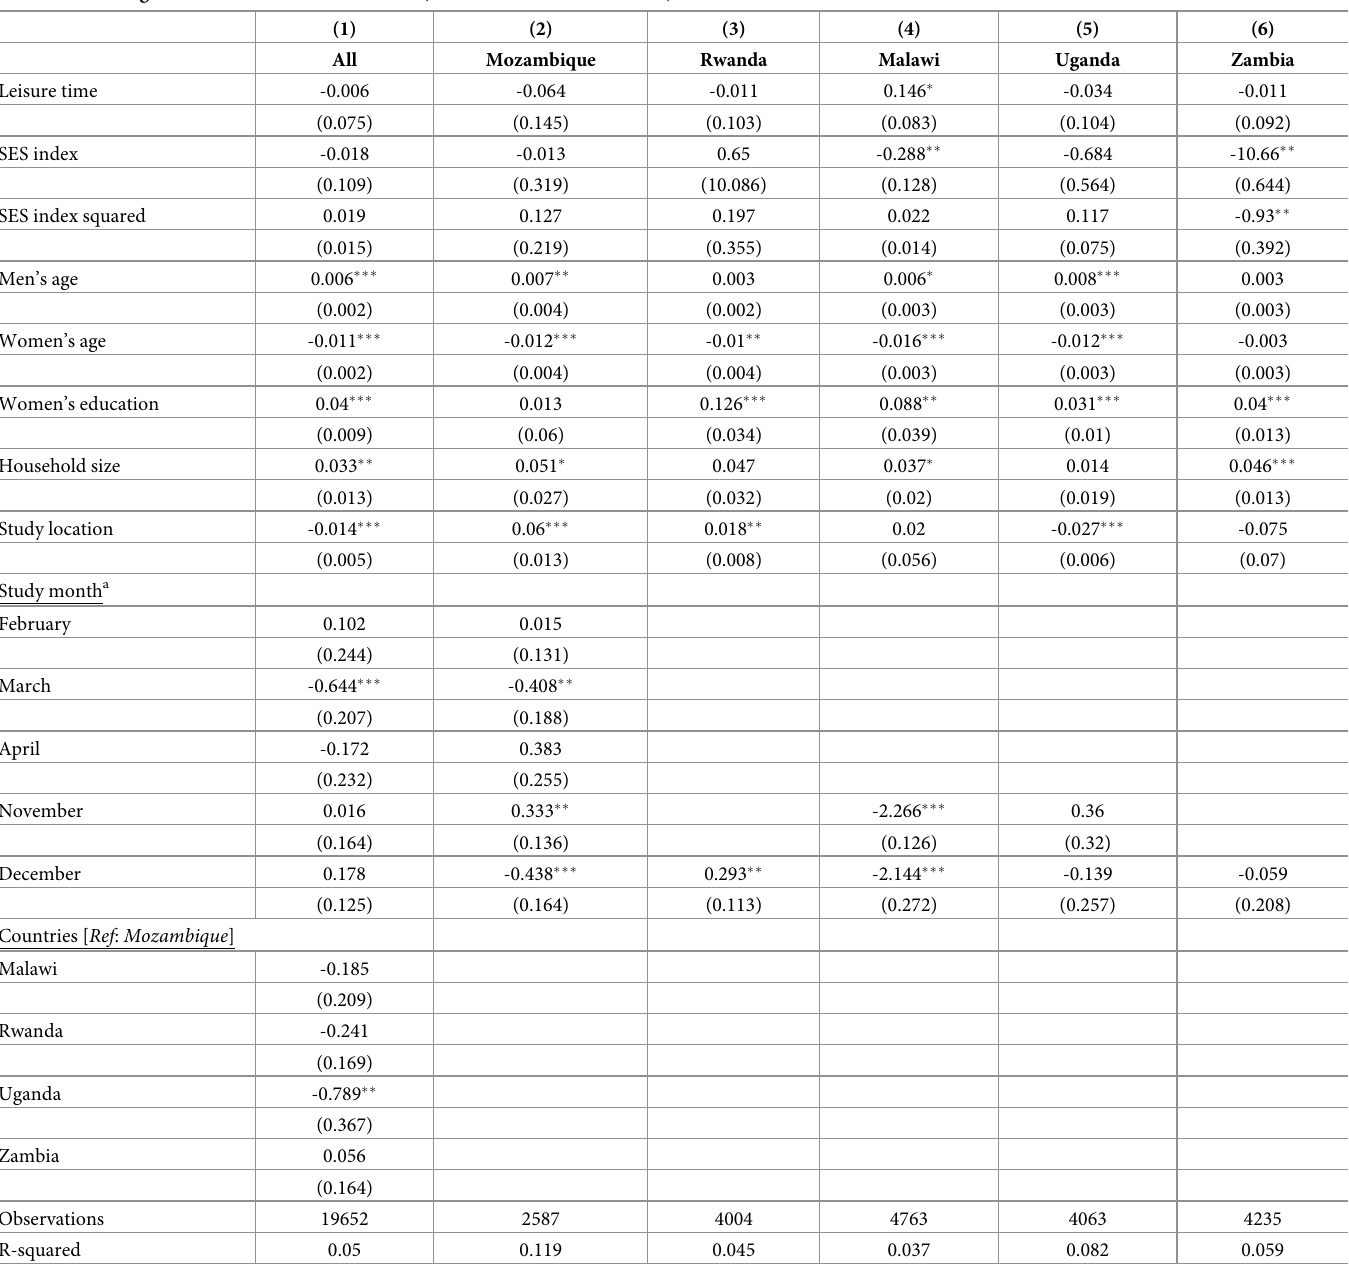
Table 14. OLS regression for WDDS–time domain (satisfaction with leisure